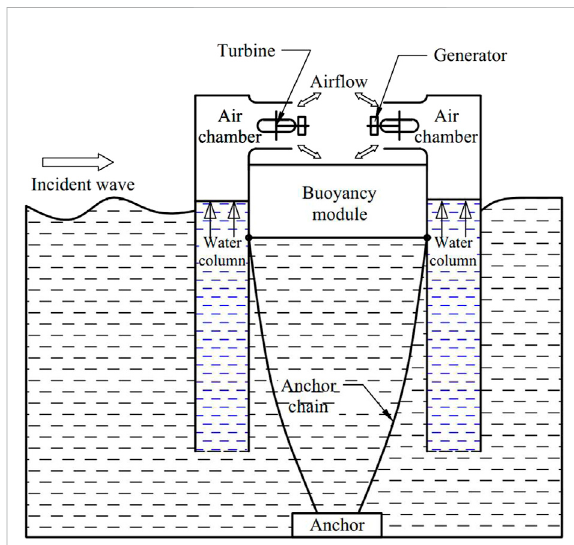
FIGURE 1 Schematic diagram of the symmetrical dual-chamber OWC wave energy converter.